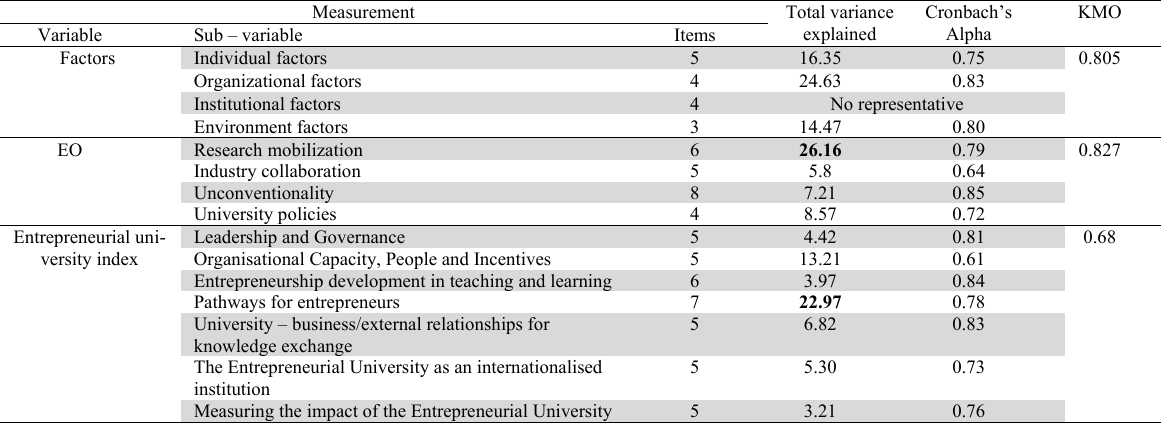
Results of component analysis